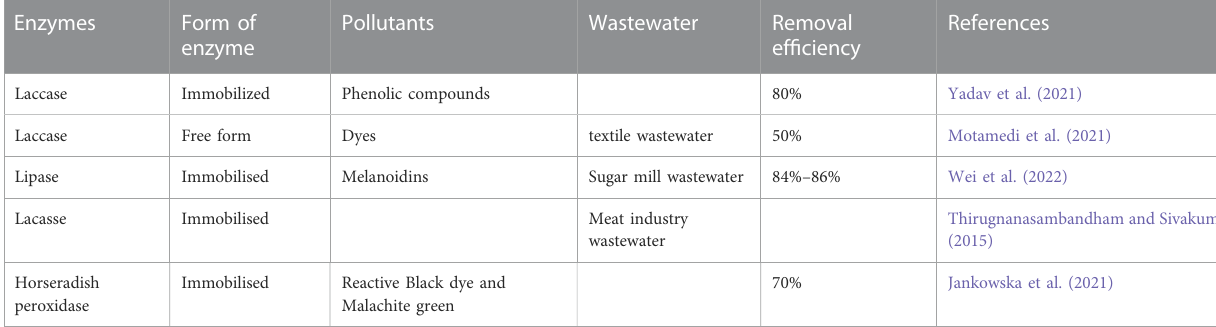
TABLE 2 Enzymes used in wastewater treatment with removal ef fi ciencies. Enzymes